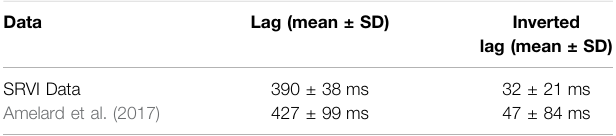
TABLE 1 | Comparison of lag and inverted lag between SRVI and (Amelard et al., 2017) data.